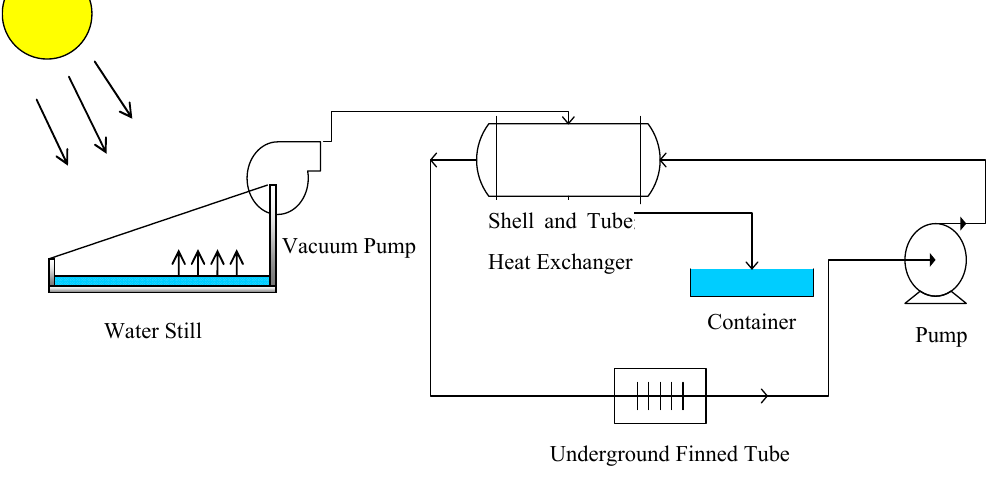
Figure 1. Proposed solar-geothermal still.